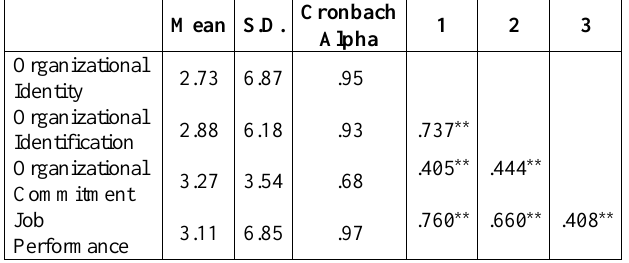
Table 2: Correlations, Means, and Standard Deviations